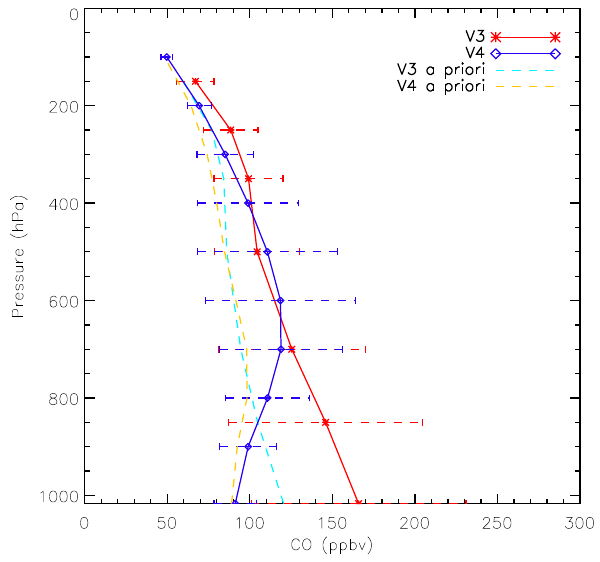
Fig. 3. MOPITT V3 and V4 mean CO profiles (solid red line and blue line, respectively) and standard deviation relative to their means (dashed horizontal lines) for 1 September 2007 over the Southern Africa region, for the daytime and over the ocean. The MOPITT V3 a priori profile (dashed turquoise line), and mean MOPITT V4 a priori profile (dashed yellow line) used in the retrievals are also shown. Fig. 4. CO total column density over Southern Africa during the daytime of 1 September 2007 : (A) IASI, (B) MOPITT V3, (C) MOPITT V4, and (D) GEOS-Chem.